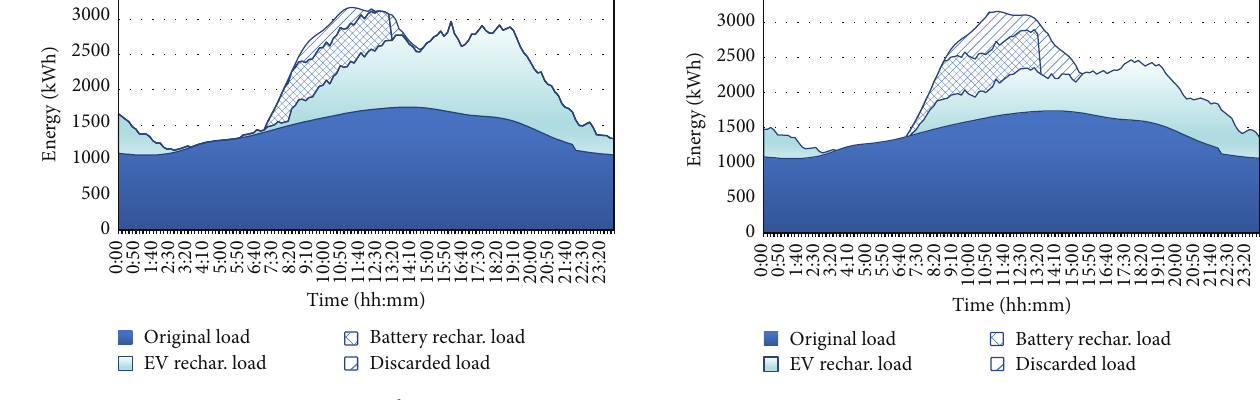
Figure 13: HRES energy supply with 60% EVSE